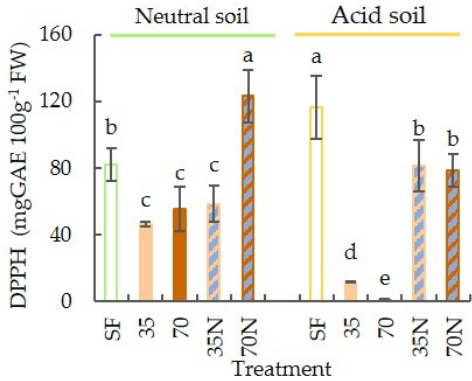
Figure 9. Effects of soil and MSWC supplemented or not with inorganic nitrogen on shoot antioxidant activity (DPPH) levels. Note: FS—fertilized soil; 35—35 t MSW compost ha − 1 ; 70—70 t activity (DPPH) levels. Note: FS—fertilized soil; 35—35 t MSW compost ha